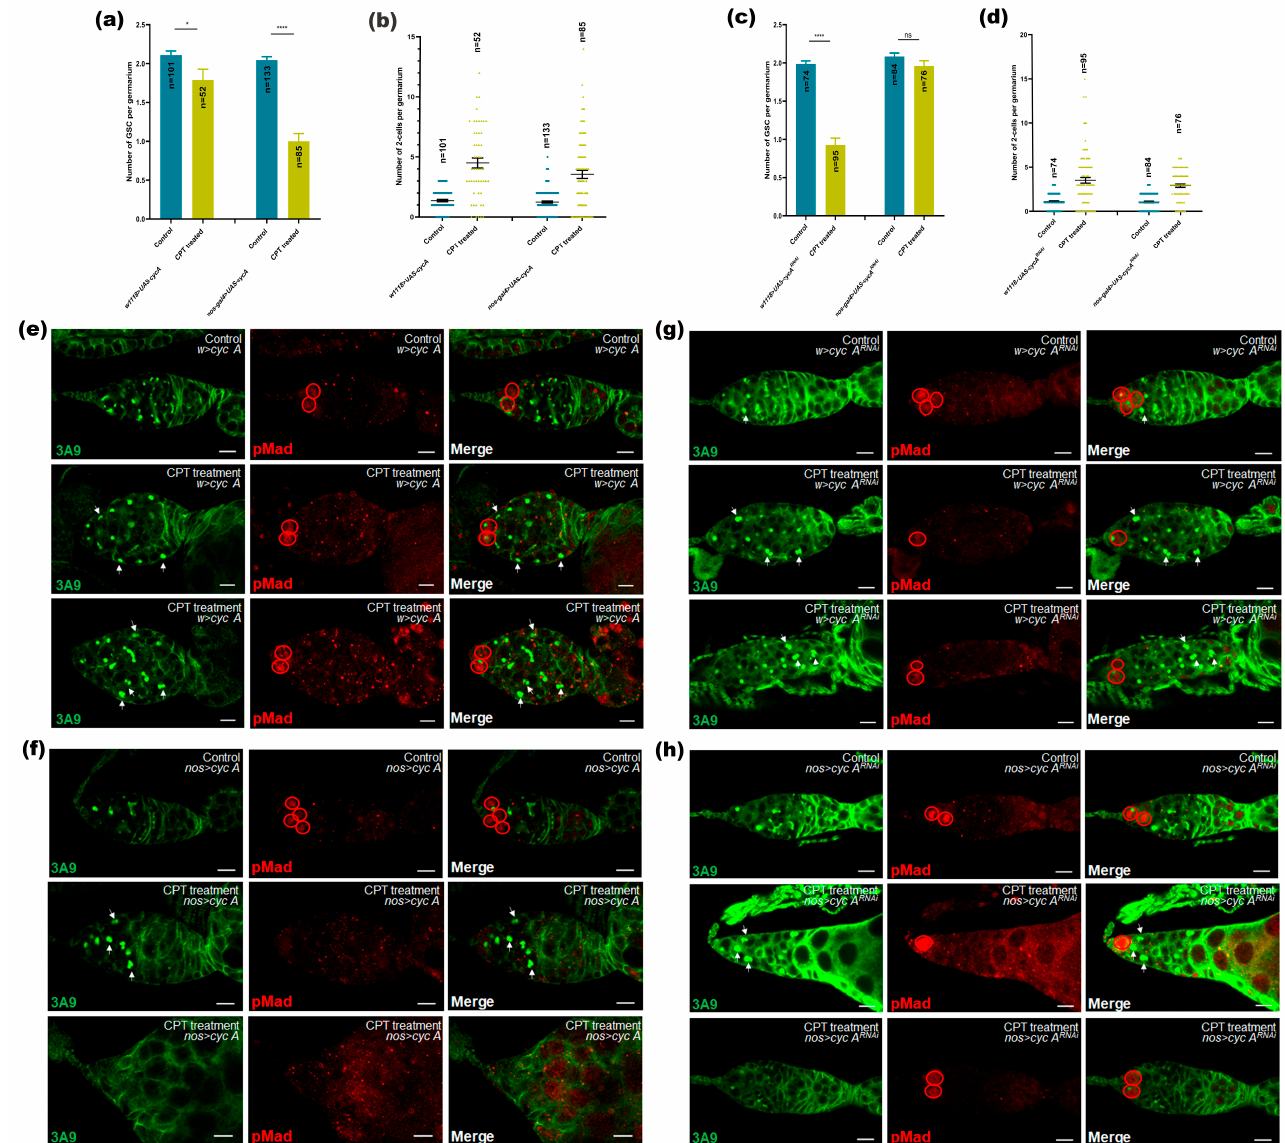
Figure 8. CycA is involved in GSC loss and two-cell accumulation induced by CPT treatment. ( a ) The GSC number of control and CycA overexpression germaria. ( b ) The number of two-cell cysts in control and CycA overexpression germaria. ( c ) The number of GSCs in control and CycA RNAi germaria. ( d ) The number of two-cell cysts in control and CycA RNAi germaria. ( e , f ) Control and CycA overexpression germaria with or without CPT treatment and stained with anti-pMad (red) and anti-3A9 (green). Blue indicated control, yellow indicated CPT treatment in ( c , d , e , f ). ( g – h ) Control and CycA RNAi germaria with or without CPT treatment and stained with anti-pMad (red) and anti-3A9 (green). Statistical comparisons were based on Students’ s t -tests. The level of significance for the results was set at * p < 0.05, **** p < 0.0001. Scale bar, 10 μ m.